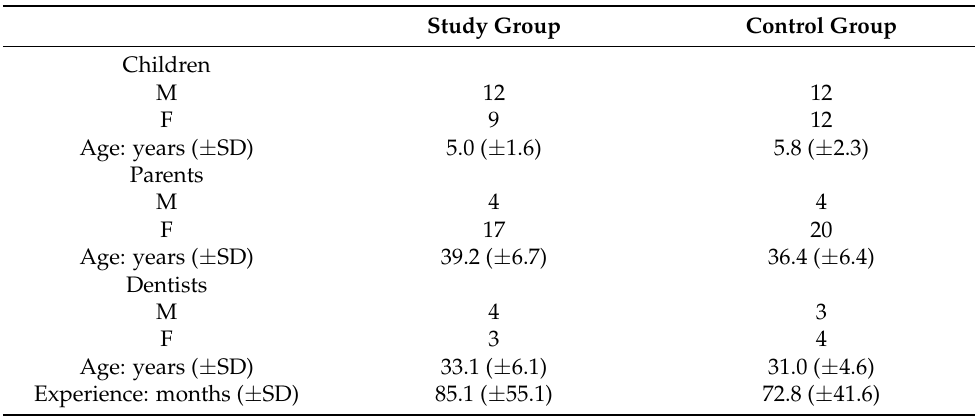
Table 1. Descriptive characteristics of the study and the control group.